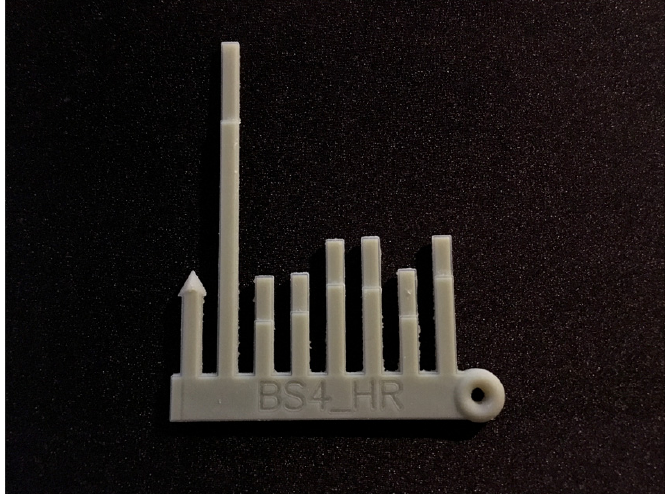
Figure 1. 3D-printed model of moderate-to-vigorous physical activity across a week. In total, 61 participants (36 boys; 10.9 ± 3.0 years) recruited from the wider intervention study, as described in detail elsewhere [10], provided informed parental/carer consent and child assent to participate in this study. Specifically, thirty-one children (7.9 ± 0.3 years; 17 boys) and thirty adolescents (13.8 ± 0.4 years; 22 boys) were included. A purposive sampling approach was employed, whereby only participants who took part in the overall intervention and received 3D models, were approached. Following prior stratification into high and low socioeconomic status groups, based on the percentage of pupils eligible for free school meals, 34 and 27 individuals, respectively, were invited to take part in focus groups. Focus groups were employed as they enable a researcher to tap into